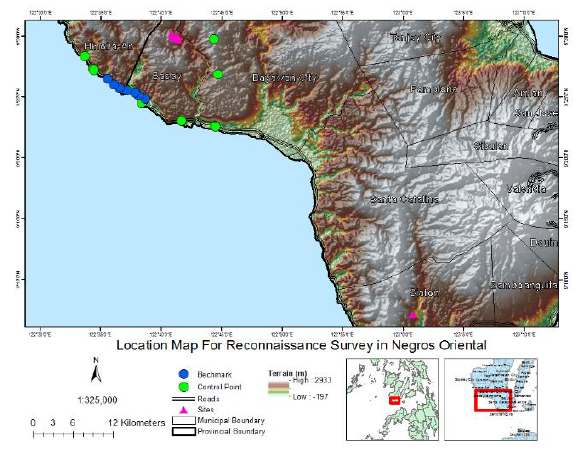
Figure 1. Location map of study site in Basay, Negros